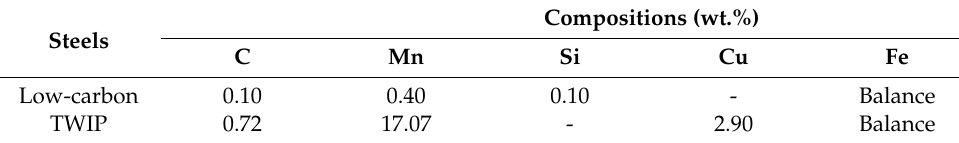
Table 1. Chemical compositions of the low-carbon and TWIP steels used in this study. Compositions (wt.%) Steels Low-carbon